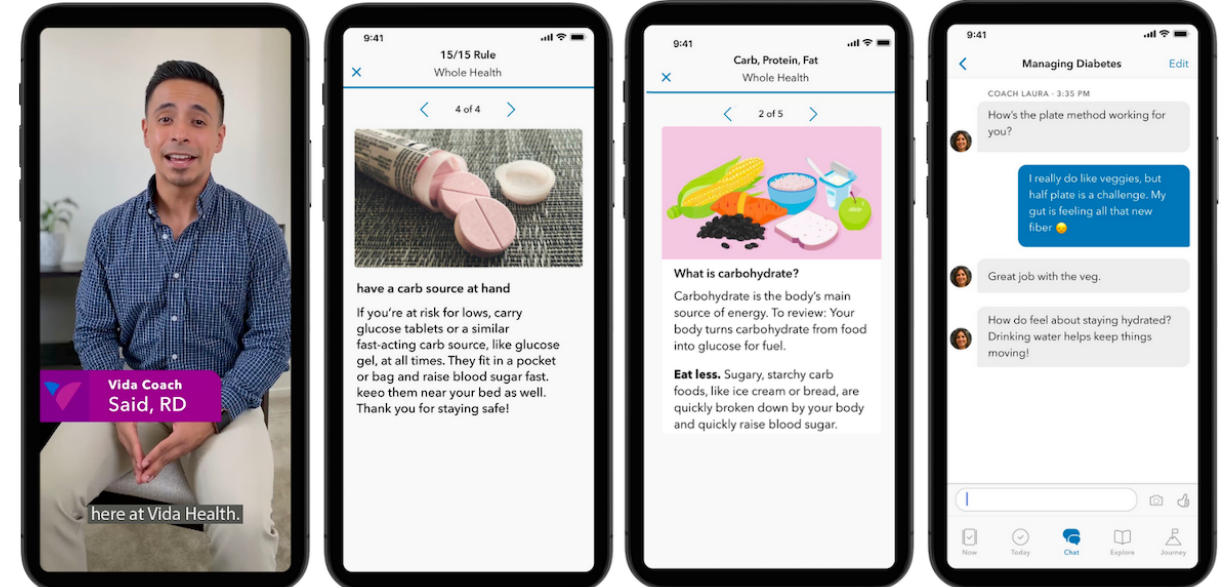
Figure 1. Vida Health educational content